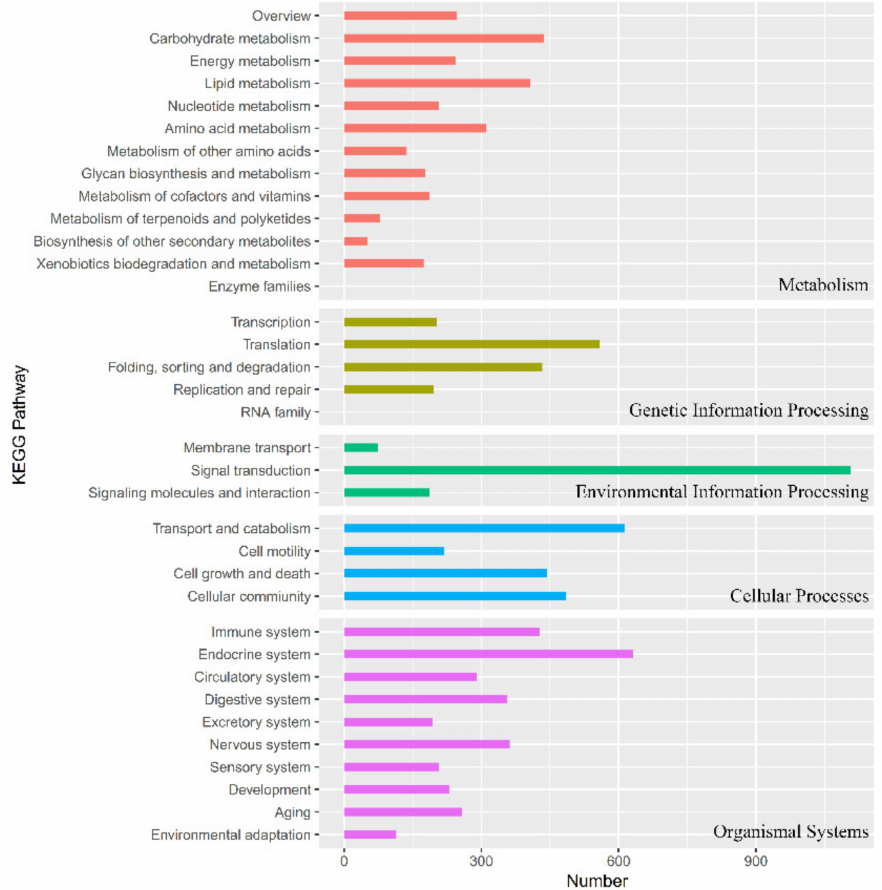
Figure 3. KEGG pathway annotation. KEGG Orthology (KO) and pathway annotations were completed by KEGG Automatic Annotation Server (KAAS) online automated annotation system. Numbers of matched unigenes were plotted against different KEGG